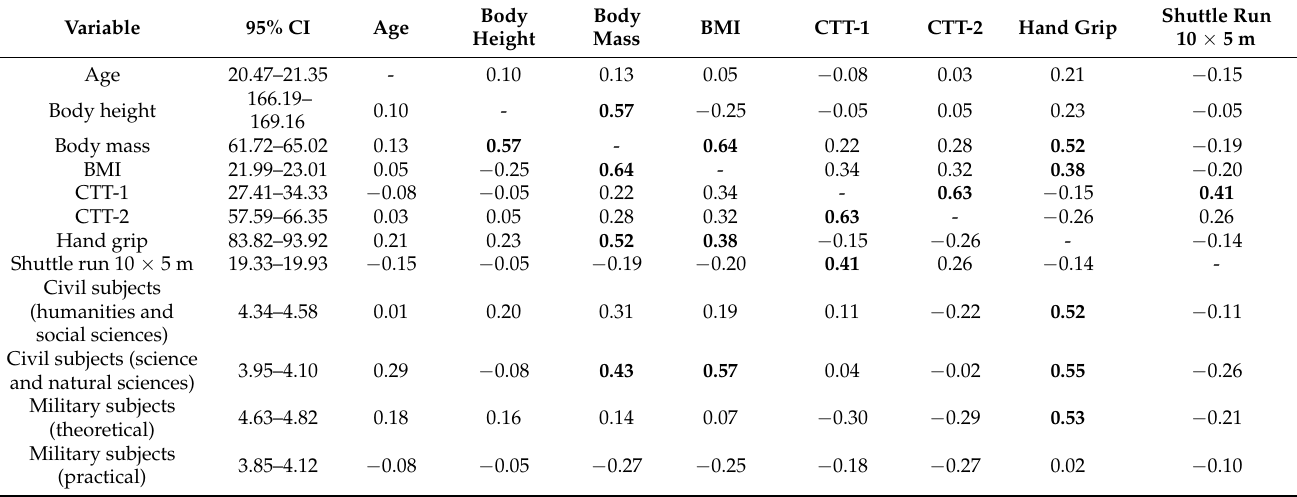
Table 2. Correlations between the studied characteristics in the female group. Bold, highlighted correlation coefficients are significant with p < 0.05.